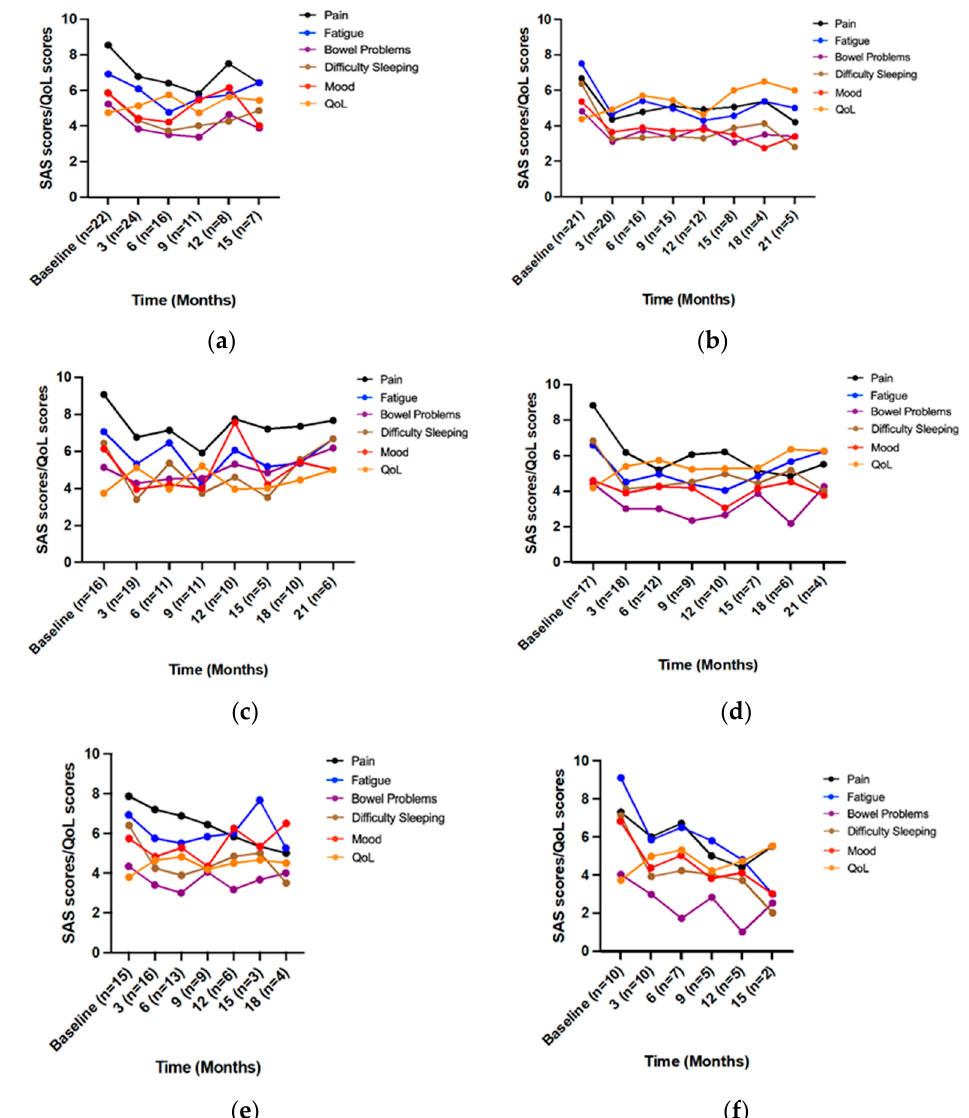
Figure 3. Mean symptom assessment scale scores for patients with a condition assessing symptom distress (10 = worst) and quality of life scores (10 = best). ( a ) Spondylosis (to 15 months); ( b ) Parkin- son’s disease (to 21 months); ( c ) Chronic pain syndrome (to 21 months); ( d ) Combined neuropathic pain and peripheral neuropathy (to 21 months); ( e ) Migraine (to 18 months); ( f ) Multiple sclerosis (to 15 months). n = number of patients contributing data at each timepoint; QoL: Quality of life; SAS: Symptom Assessment Scale.